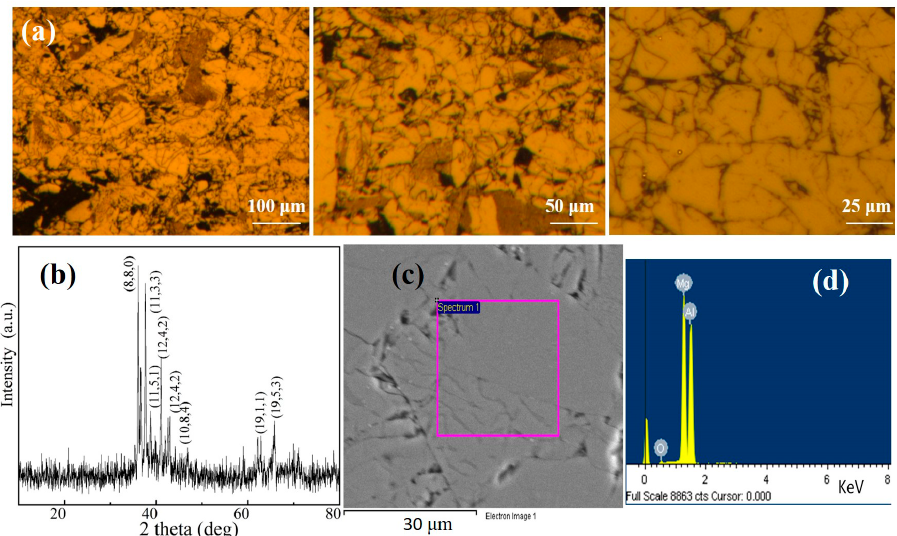
Figure 2. ( a ) The metallography of the Al 3 Mg 2 alloy with different magnification scales, ( b ) XRD patterns of the Al 3 Mg 2 alloy, and ( c , d ) scanning electron microscopy and corresponding energy dispersive spectra of the Al 3 Mg 2 alloy.